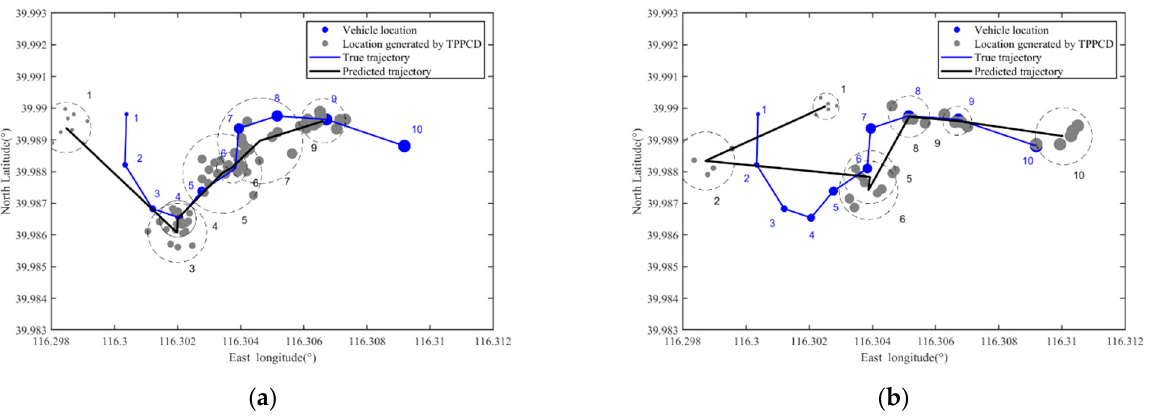
Figure 10. The predicted trajectory of a vehicle user with TPPCD. ( a ) V = 0.95 γ = 0.5; ( b ) V = 0.95 γ = . .